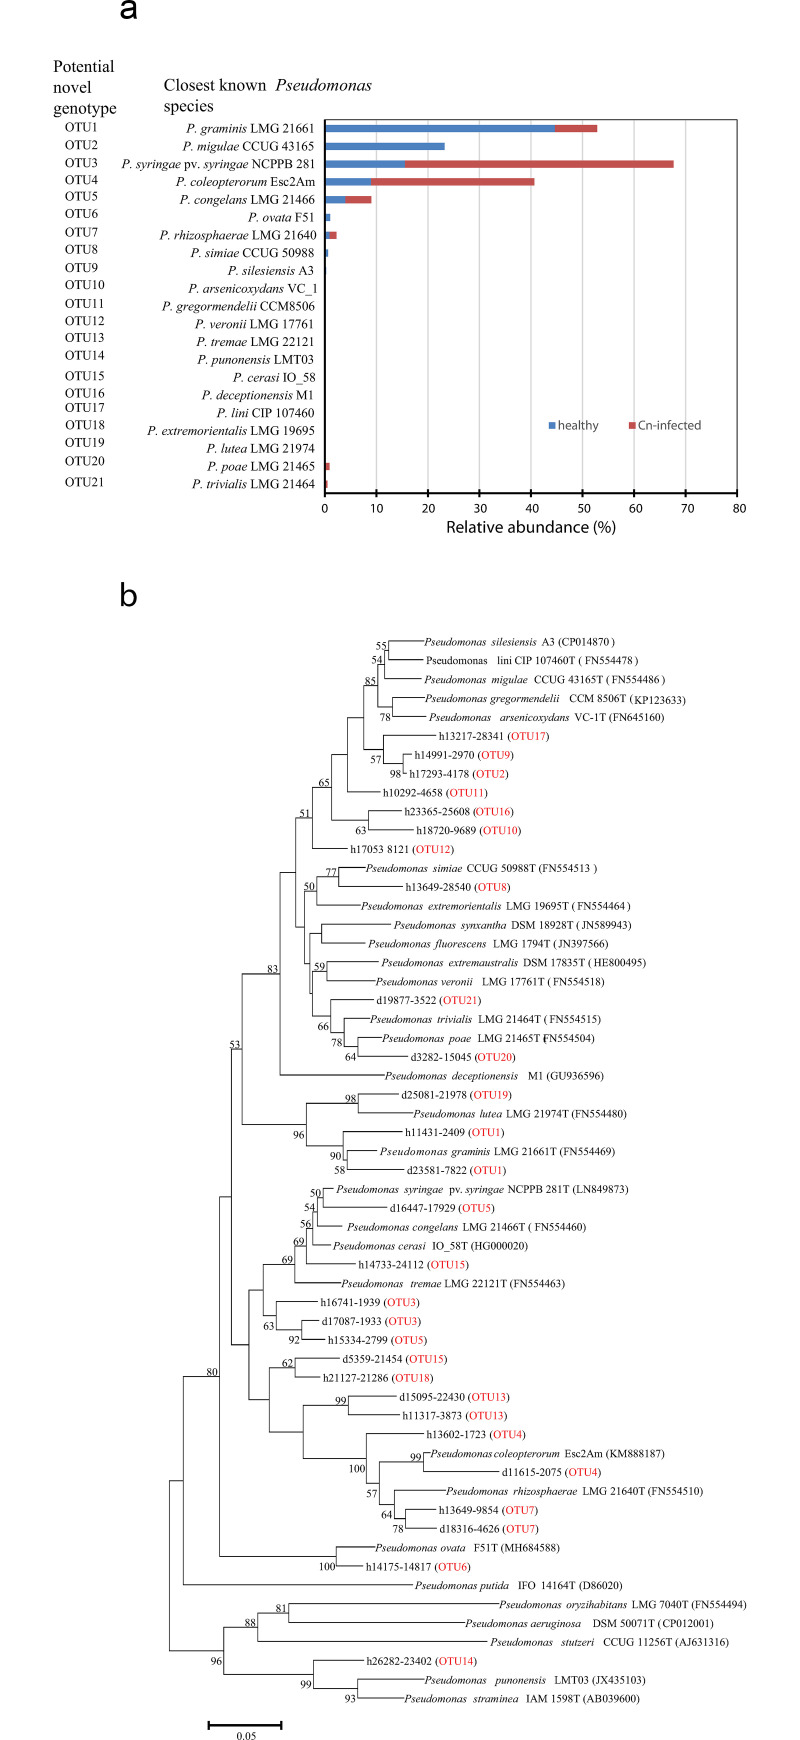
(a) Relative abundance of operational taxonomical units (OTUs) considered as novel genotypes based on nucleotide homology cut-off identity <95% (86.4–94.6%) in healthy and diseased (Cn-infected) leaf samples and the corresponding closest validly described type strain of Pseudomonas species; and (b) phylogenetic tree of potential novel Pseudomonas genotypes based on a 400-nucleotide rpoD gene fragment. OTU codes (red) starting with the letter ‘d’ were from diseased sample while codes with ‘h’ are from healthy leaf samples. Note: OTUs clustering uniquely from validly published type strains. OTUs from the diseased and healthy showing high nucleotide similarities clustered together.